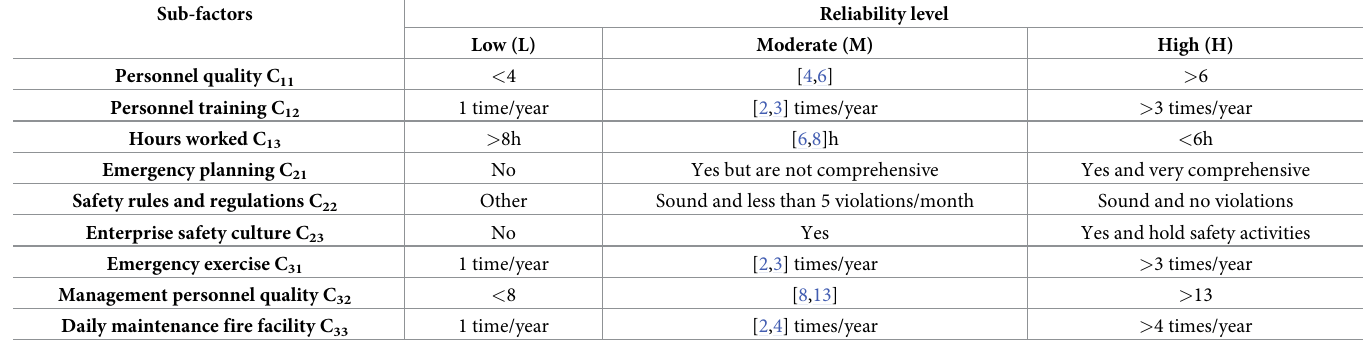
Table 11. Parameter ranges corresponding to the three levels of emergency response.